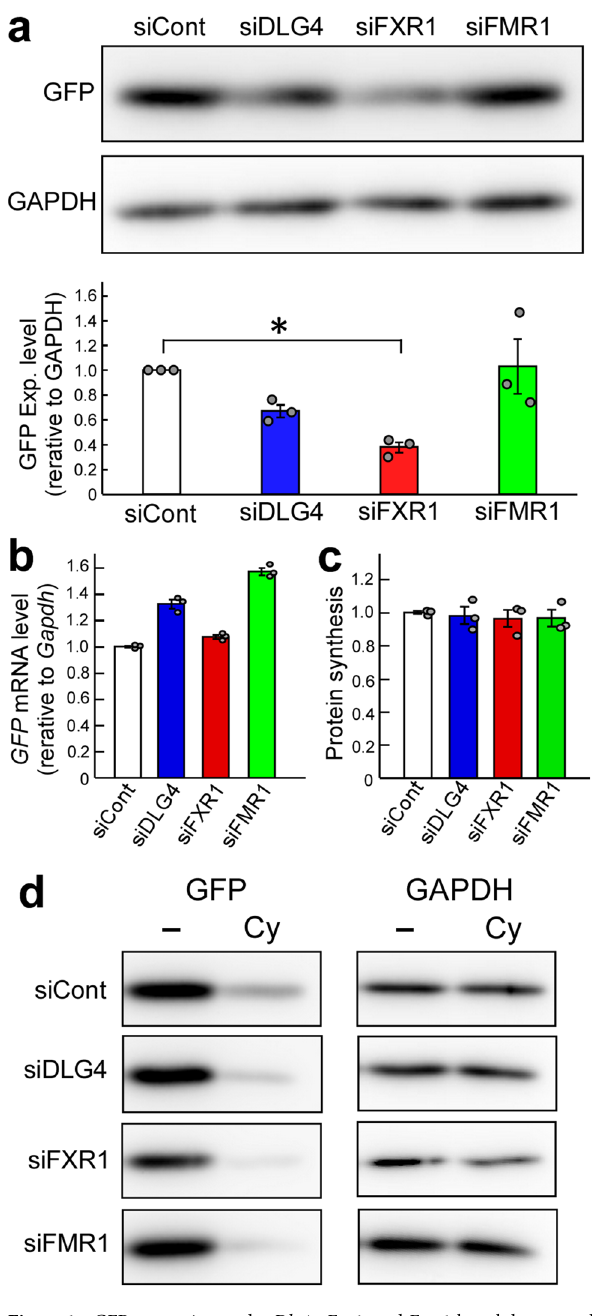
Figure 1. GFP expression under Dlg4 -, Fxr1 - and Fmr1 -knockdown conditions. ( a ) GFP expression. The pd2EGFP-N1 plasmid encoding the GFP gene was transfected into N2a cells with the indicated siRNAs. siCont: a non-silencing control siRNA. 48 h after transfection, cell lysate was prepared and divided into two portions for western blotting and qRT-PCR analyses. Protein concentrations were measured, and equal amounts of lysates were examined by western blotting with anti-GFP and GAPDH antibodies. The experiment was triplicated (the other two blots are shown in Supplementary Fig. 1), and signal intensities of GFP and GAPDH bands were measured with the ImageJ software. GFP intensities were normalized by GAPDH intensities and further normalized by the data obtained from cells treated with siCont as 1. Data are shown as mean ± SEM ( n = 3 examinations, * P < 0.05 by one-way analysis of variance with Dunnett’s post hoc tests). ( b ) GFP transcript amount. Total RNAs were extracted from the same N2a cells as in ( a) , and the GFP and Gapdh transcripts were examined by qRT-PCR. The data were analyzed by the delta-delta Ct method using the Gapdh data as a reference and normalized by the data obtained from cells treated with siCont as 1. Data are shown as mean ± SEM (n = 3 independent determination). ( c ) Protein synthesis level. Overall nascent proteins under gene knockdown conditions (indicated) were examined by a protein synthesis assay kit. Fluorescently labeled nascent proteins were measured and signal intensities were averaged. The data were further normalized by the data obtained from cells treated with siCont. Data are shown as mean ± SEM (n = 3 independent determination). ( d ) Protein stability. Protein stability was examined using cycloheximide as a translation inhibitor. N2a cells transfected as in (a) were treated with cycloheximide (Cy) and its vehicle (-) (DMSO) for 9 h and examined by western blotting as in ( a